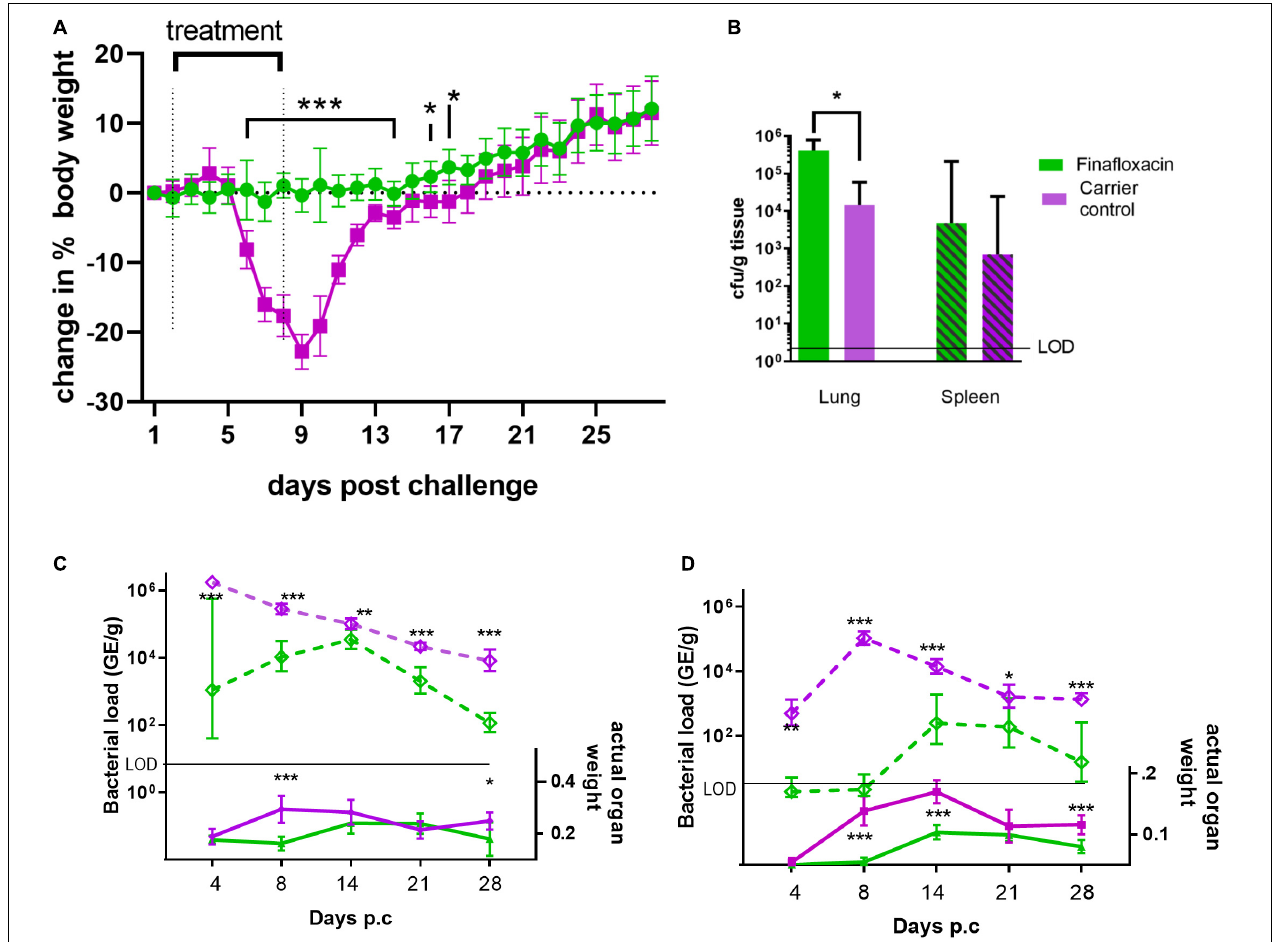
FIGURE 3 | Body weight, organ weight and bacterial burden in mice infected with C. burnetii and treated with finafloxacin for 7 days. At 24 h post-challenge mice were treated with finafloxacin (30 mg/kg) or the carrier once a day orally for 7 days. (A) Body weight change from baseline, (B) bacterial burden for lung and spleen determined by viable counts on day 14 p.c. (C) Actual Lung weight (solid line) and bacterial burden assessed by RT-PCR (dotted line) on days 4, 8, 14, 21 and 28 p.c. (D) Actual spleen weight (solid line) and bacterial burden assessed by RT-PCR (dotted line) on days 4, 8, 14, 21 and 28 pc. Mean and SEs are shown for weights, geometric mean and SD for GE or cfu, limit of detection marked LOD. * p < 0.05, ** p < 0.01, *** p <